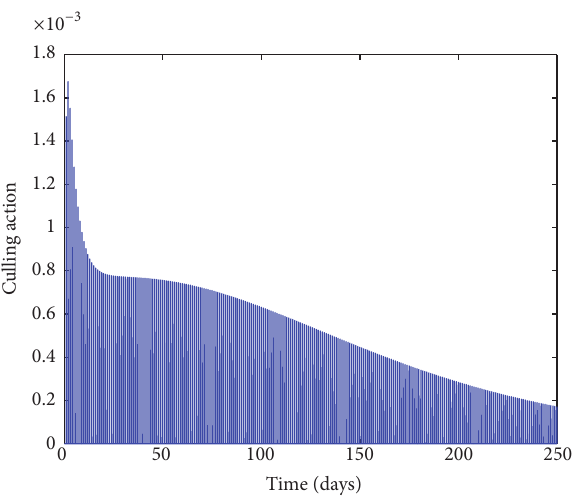
Figure 10: Culling effort 𝜌 𝐷 𝐷(𝑡) with a daily culling rate of 𝜌 𝐷 = 0.8 .